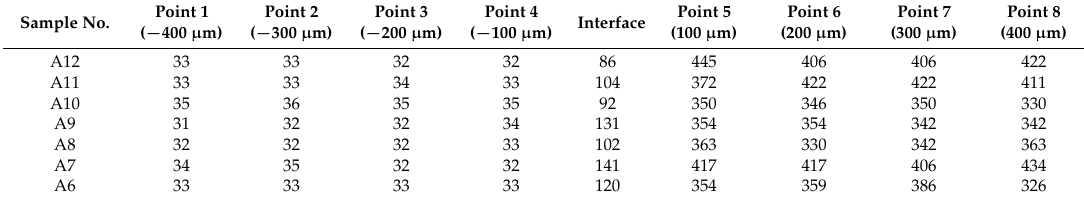
Table 4. Microhardness test results for all samples with different points.